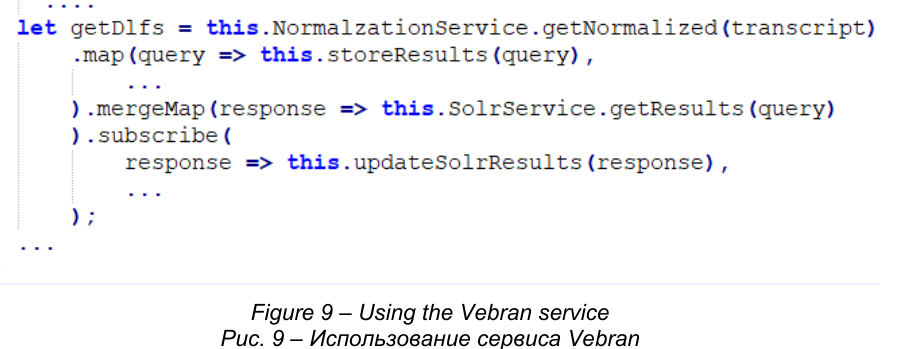
Figure 9 – Using the Vebran service Рис . 9 – Использование сервиса Vebran Слика 9 – Коришћење Vebran